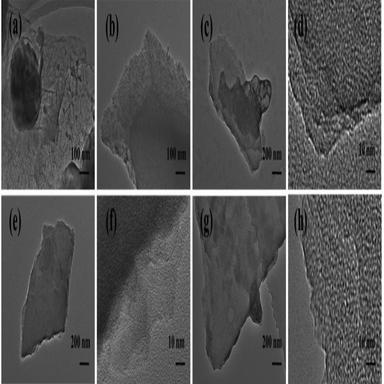
TEM images of the (a) SC-900, (b) LC-900, (c–d) LEC-800, (e–f) LEC-900 and (g–h) LEC-1000 samples.